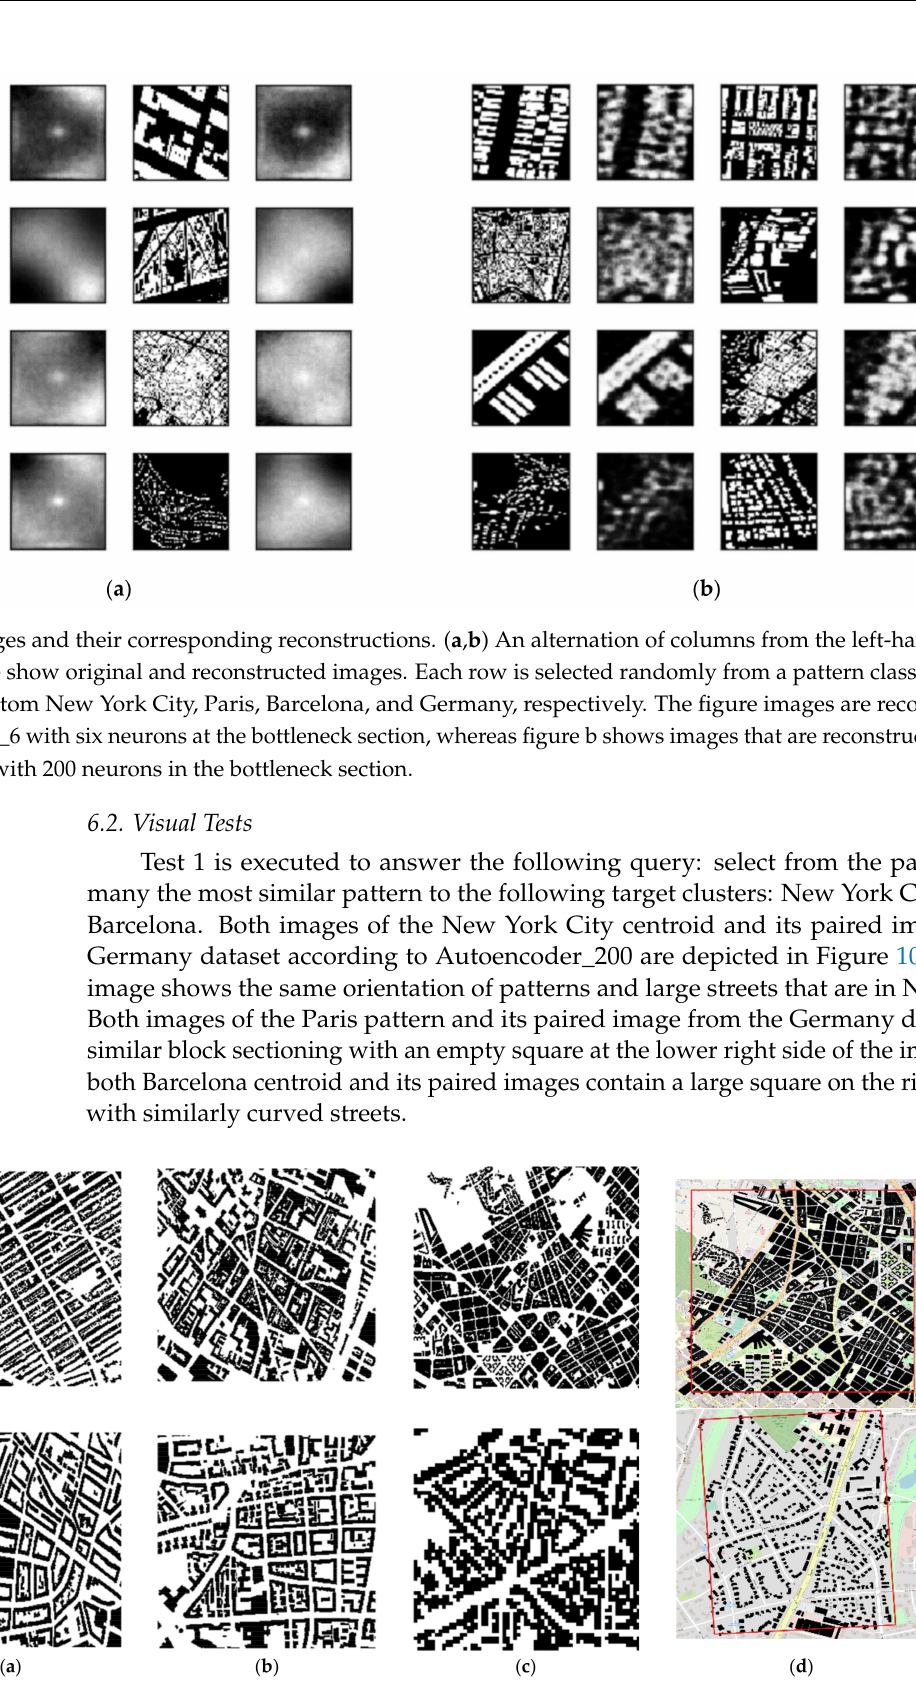
Figure 10. Results of Test 1. The top row shows the centroid of each of the clusters, which are ( a ) New York City, ( b ) Paris, and ( c ) Barcelona. The top row depicts the image that is most similar to the centroid. The last column ( d ) is a repetition of the Barcelona cluster; however, it is shown in the geographical